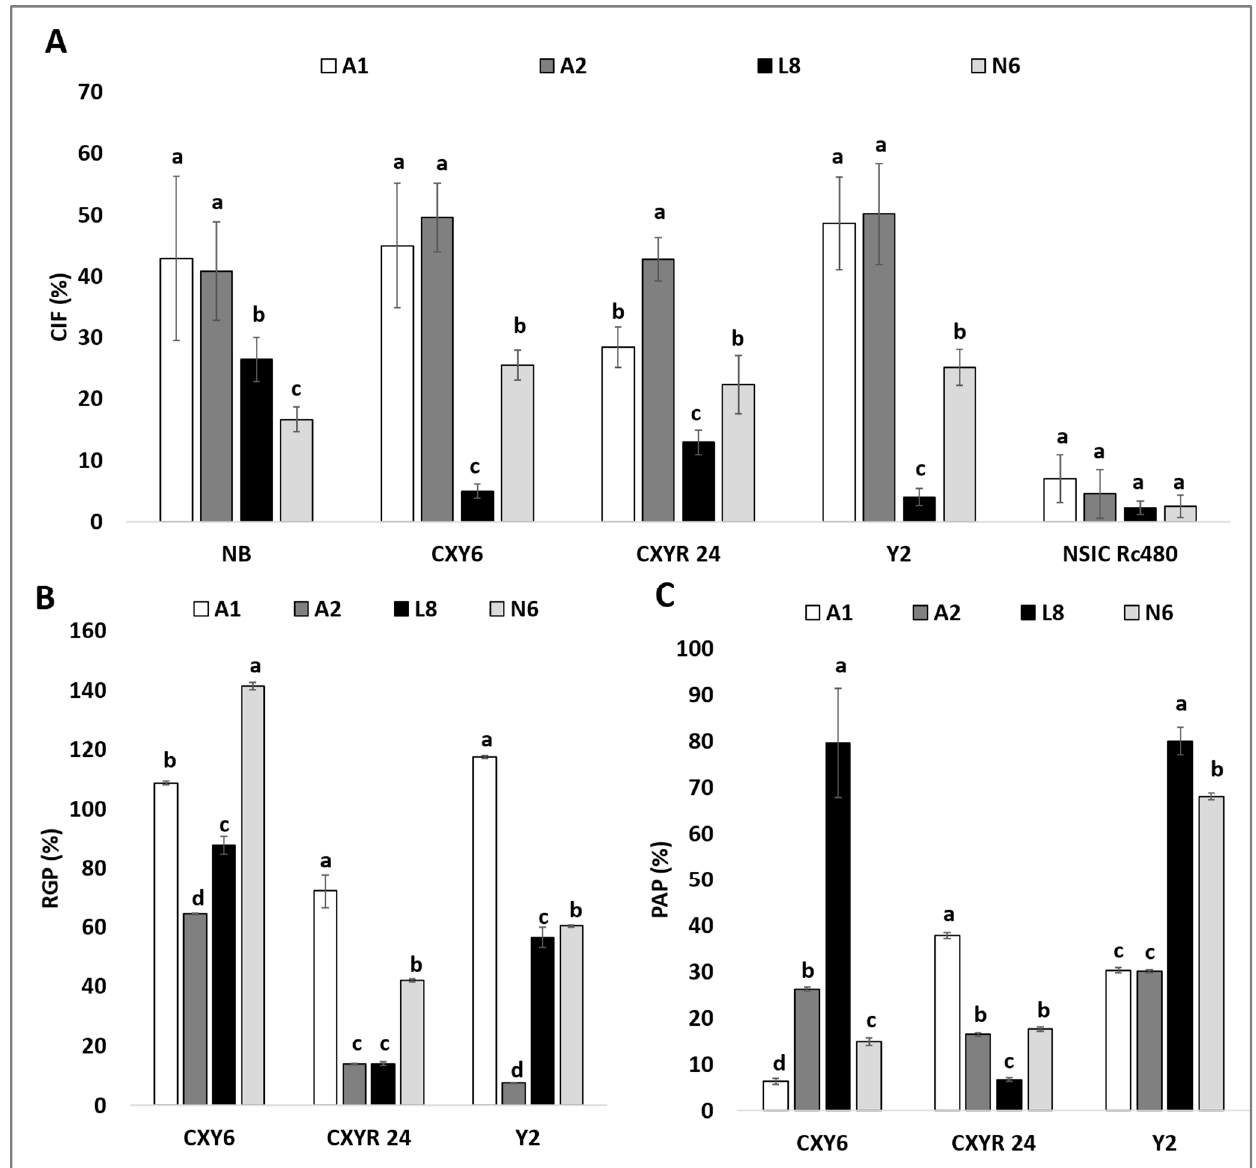
Figure 2. Callus induction frequency (CIF), green plantlet regeneration (RGP), and albino plantlet regeneration (PAP) of different genotypes in the tested media. ( A ) Comparison of callus induction frequency (CIF) of different genotypes incubated in the test media. ( B ) Comparison of green plantlet regeneration (RGP) of hybrids of indica x japonica incubated in the test media. ( C ) Comparison of the albino plantlet regeneration (PAP) of hybrids of indica x japonica incubated in the test media. The data presented are means of five replicates, and error bars represent SD. Values with different letter (a,b,c,d) per genotype are significantly different (Tukey HSD Test, p < 0.05, n = 5 replicates).